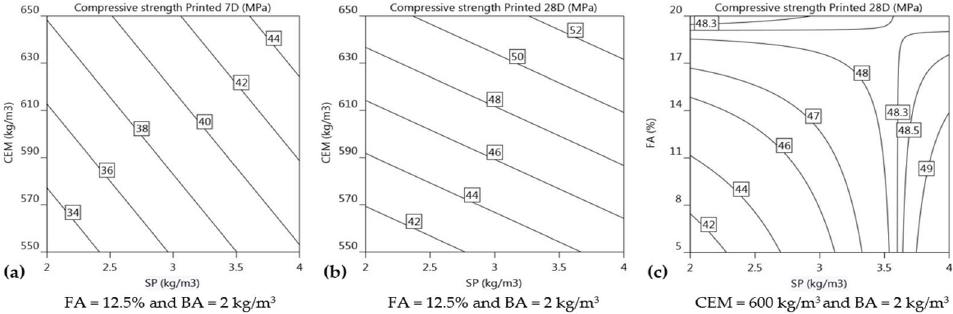
Figure 15. Isoresponse curves for compressive strength of printed members ( a ) CEM versus SP at 7 days, ( b ) CEM versus SP at 28 days, and ( c ) FA versus SP at 28 days.